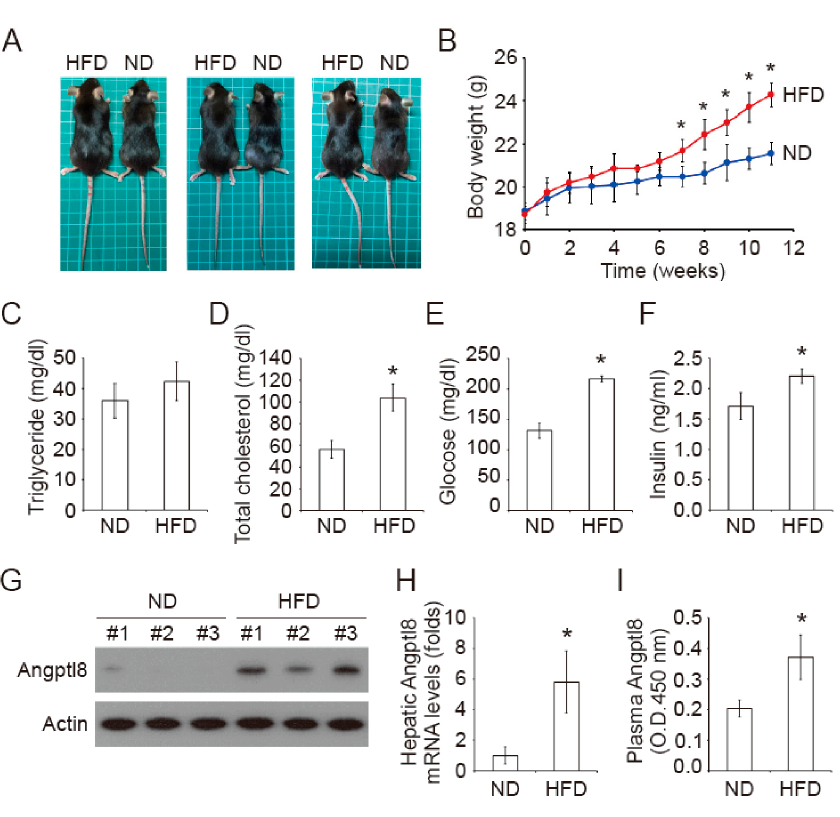
Figure 1. Characterization of the mice fed with HFD and ND. ( A ) The representative pictures showing HFD-fed and ND-fed mice. ( B ) The body weight of the mice was measured weekly; * p < 0.05, compared to the ND control group. ( C – F ) The fasting triglyceride ( C ), total cholesterol ( D ), glucose ( E ), and insulin ( F ) in the blood of the mice were analyzed; * p < 0.05, compared to the relative ND control groups. ( G ) The hepatic Angptl8 expression was examined by Western blot. ( H ) The mRNA levels of hepatic Angptl8 was analyzed by qPCR; * p < 0.05, compared to the ND control group. ( I ) The plasma Angptl8 was analyzed by ELISA; * p < 0.05, compared to the ND control